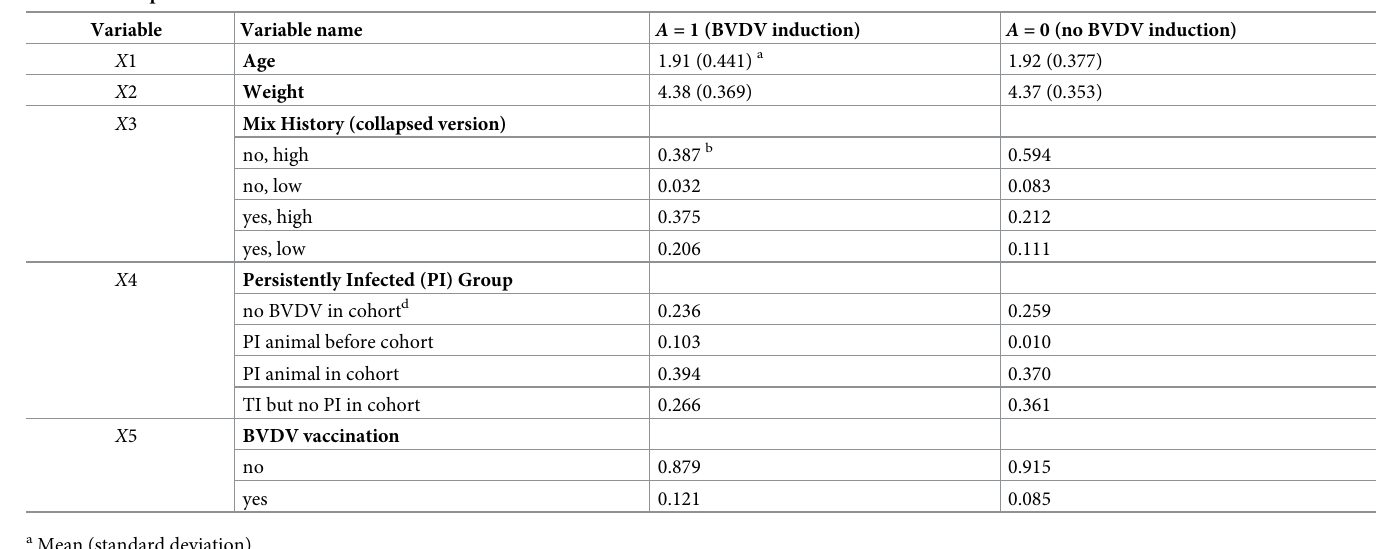
Table 2. Descriptive table for Subset-BRD dataset.